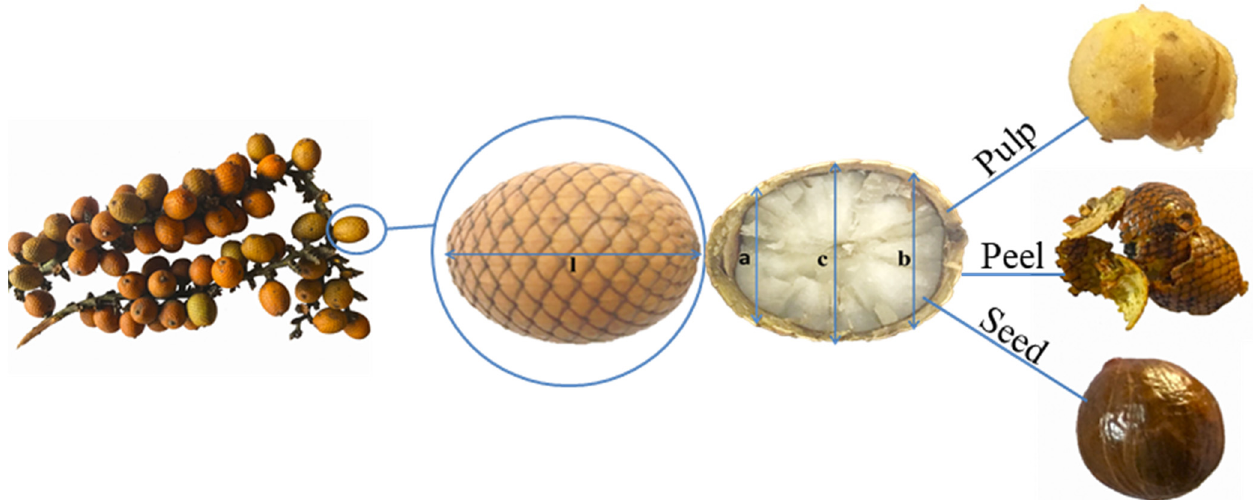
Figure 1. Buritirana fruit ( Mauritiella armata ). (l) Length; (b) basal, (c) central and (a) apical